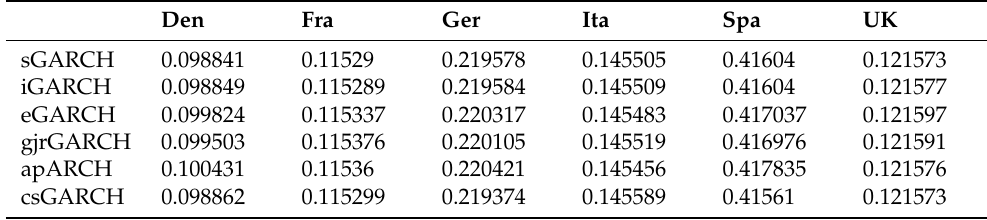
Table 2. The MSEs of the six models for all countries.